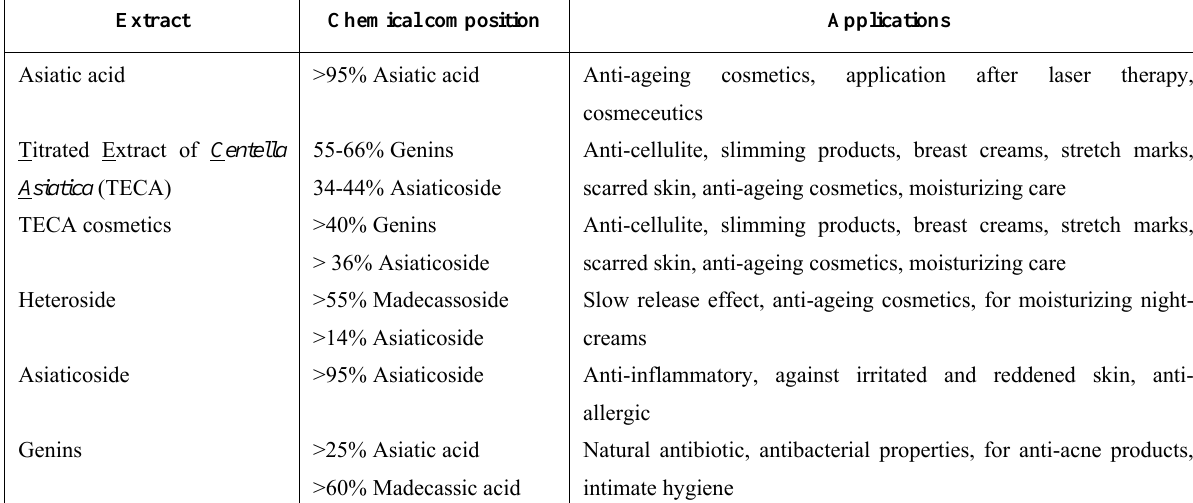
Table 2. Product range of extracts from C. asiatica indicating the specific chemical composition and treatment